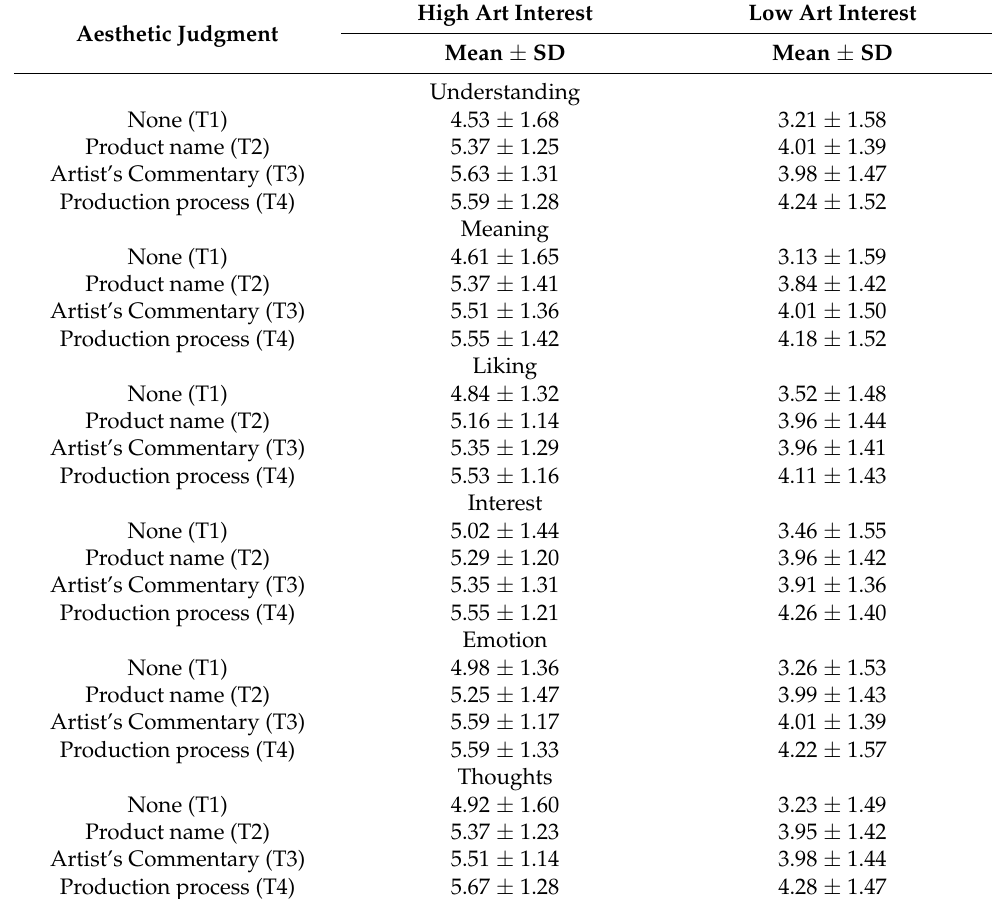
Table 7. Descriptive analysis of aesthetic